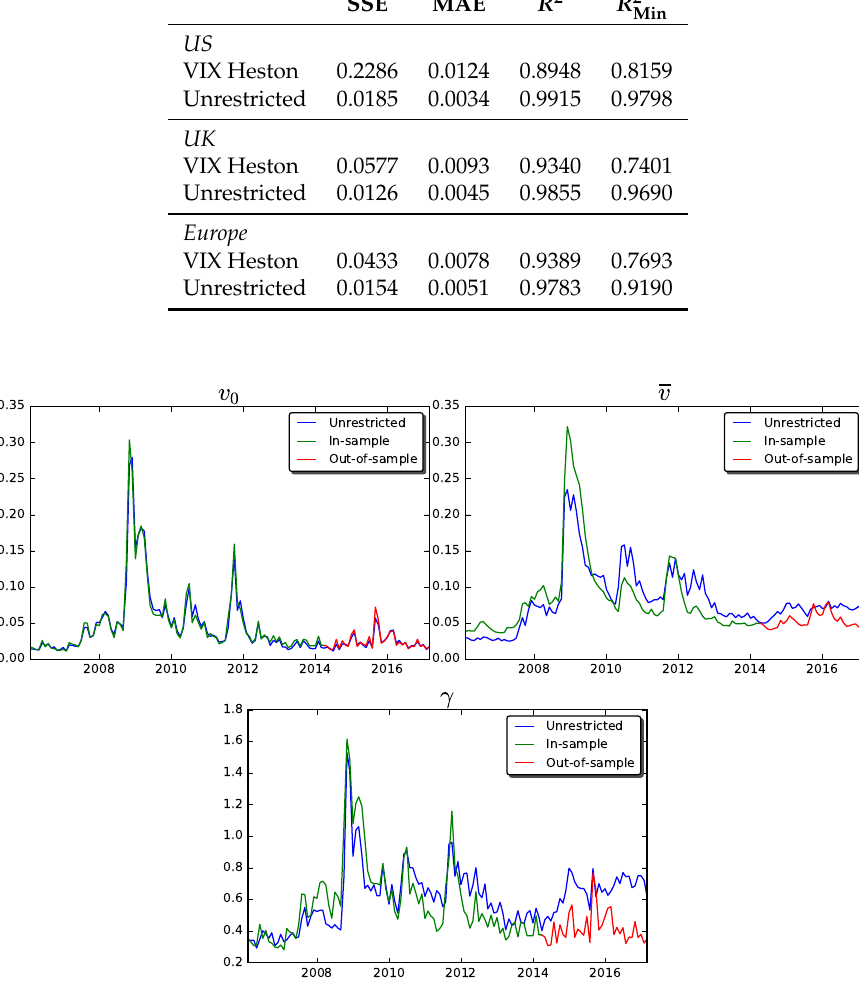
Figure 3. Prediction results Heston parameters of the US